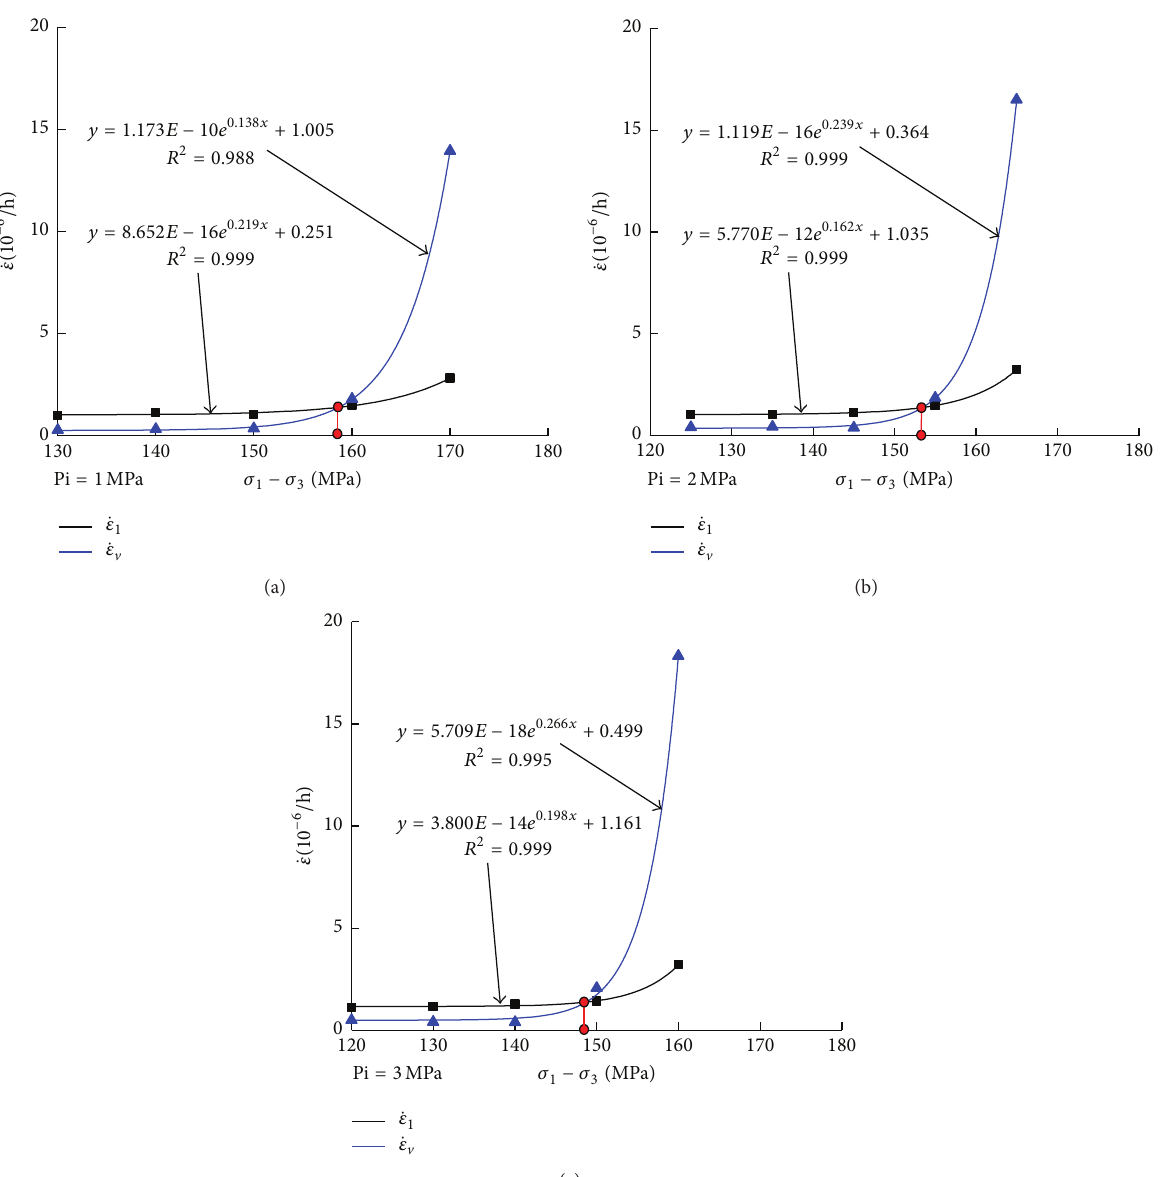
Figure 6: Curves of intersection method of steady creep rate: (a) 𝜎 3 = 4 MPa, Pi = 1MPa; (b) 𝜎 3 = 4 MPa, Pi = 2 MPa; (c) 𝜎 3 = 4 MPa, Pi = 3 MPa.